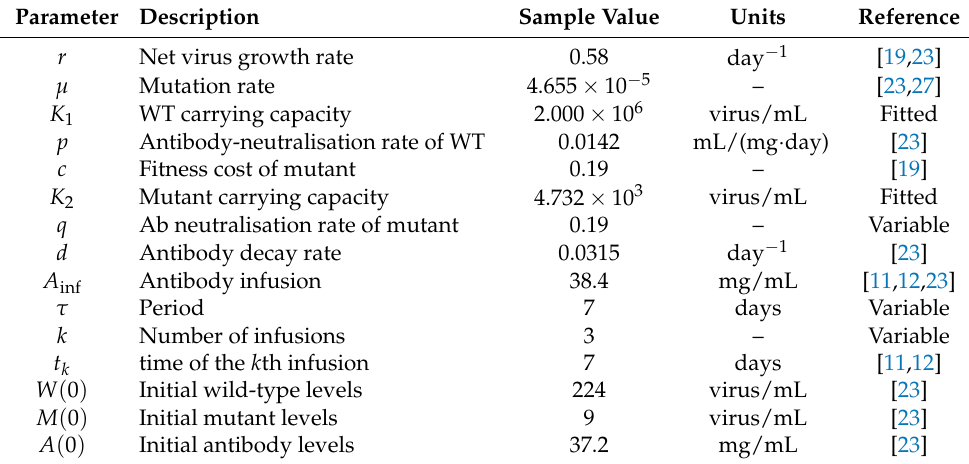
Table 1. Parameter values and initial